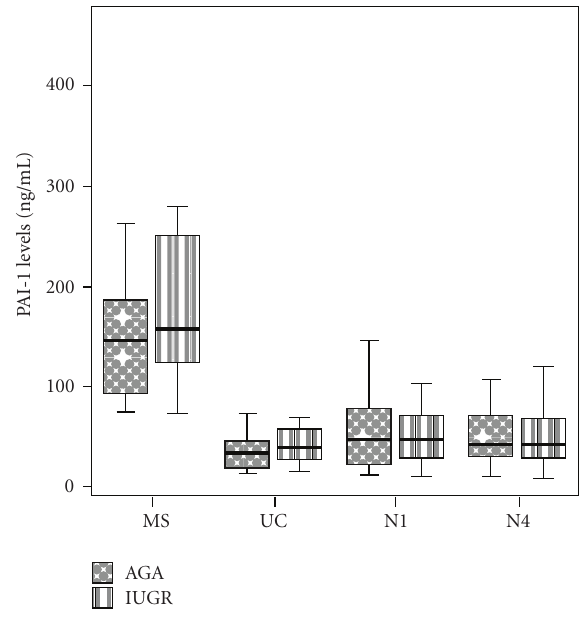
Figure 2: Box and whiskers plot presentation of maternal (MS), fetal (UC), neonatal day 1 (N1), and neonatal day 4 (N4) PAI- 1 levels. Each box represents the median concentration with the interquartile range. The upper and lower whiskers represent the